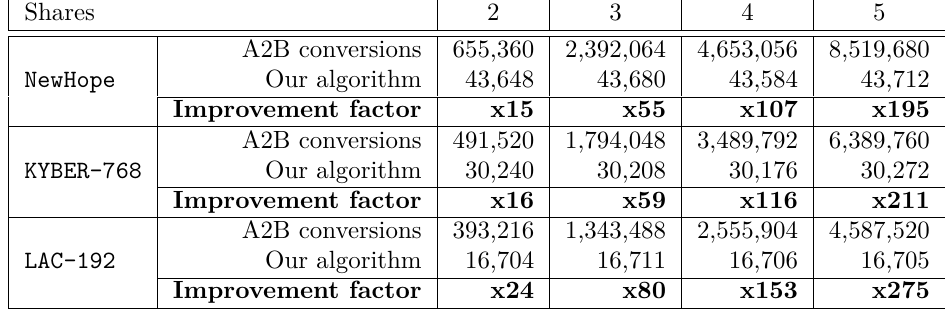
Table 3: Random bit consumption for our ARM implementations of the masked comparison for different parameter sets. All results are averaged over 100 runs.